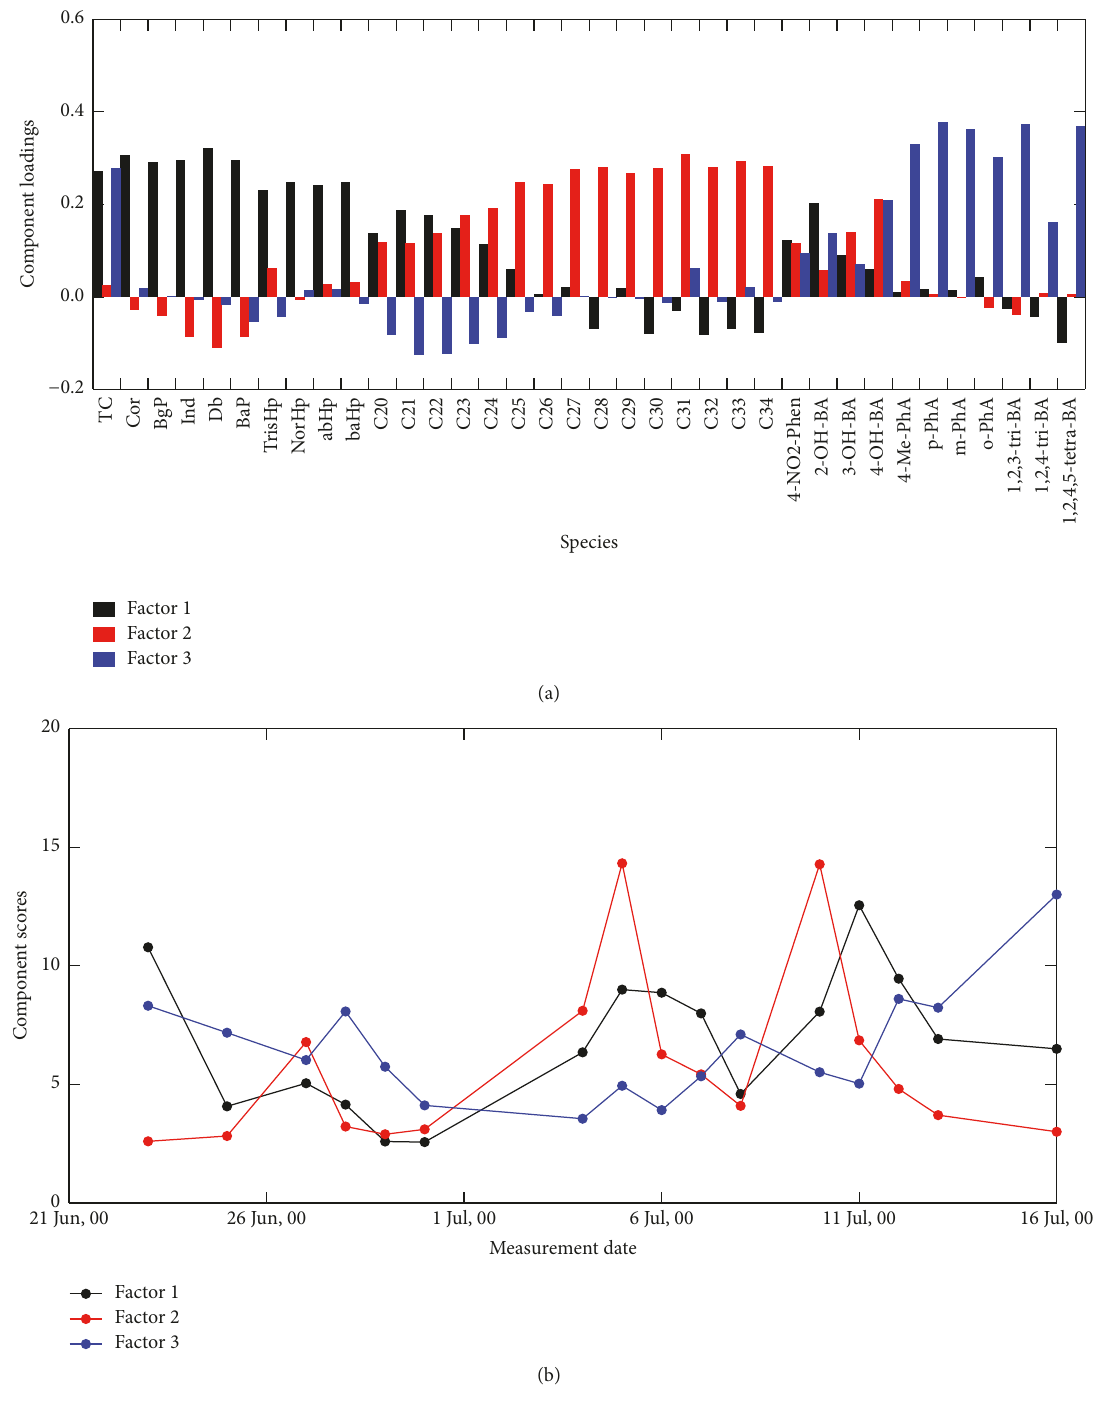
Figure 9: (a) Loading of three factorial analyses and (b) time series score of three loadings for the Hamilton dataset.